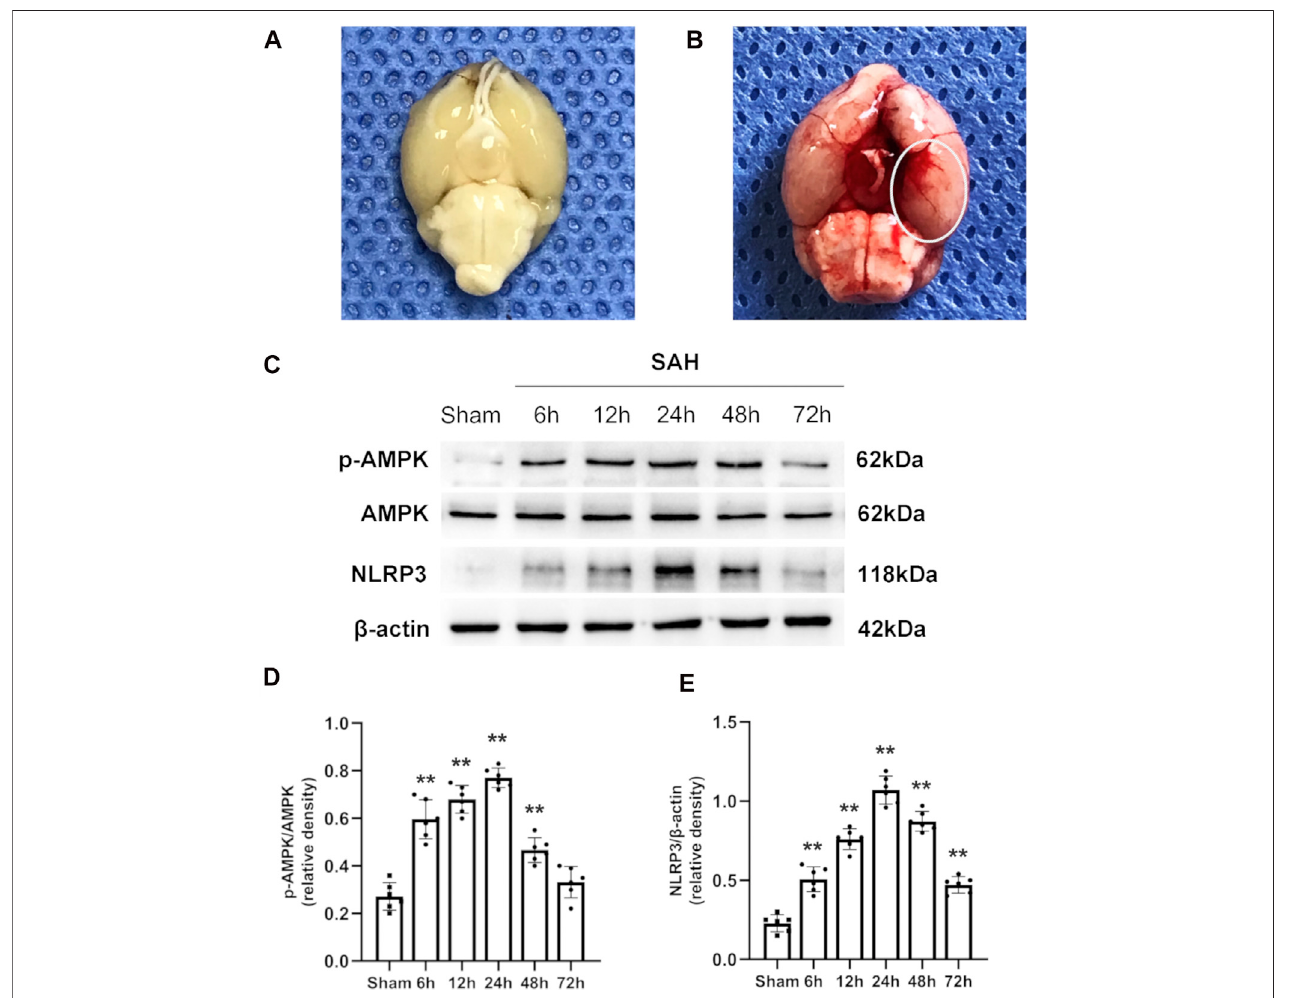
FIGURE 2 | Typical images of SAH model and expression alterations of p-AMPK/AMPK and NLRP3 in the ipsilateral hemisphere after SAH. (A,B) Representative photographs of the bottom of mice brains from sham and 24 h after SAH. The area within the white oval was speci fi cally used to observe for immunostaining. (C) Representative western blot images. (D,E) Quantitative analysisofwestern blot. Dataare expressed asthe mean ±SD using one-way ANOVA followedby Tukey ’ s post hoc test (** p < 0.01 vs Sham group, n = 6 per group).